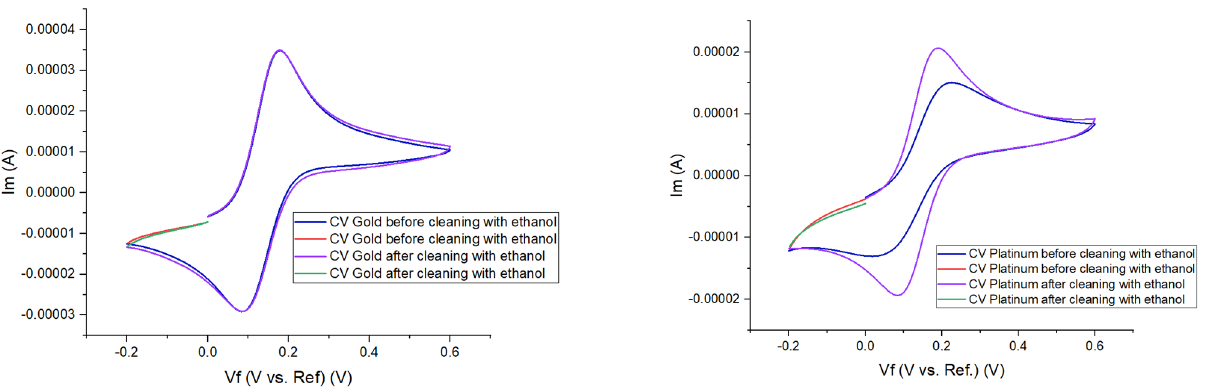
Figure 5. CV of gold and platinum electrodes before and after cleaning with ethanol: blue/red-CV before cleaning; purple/green-CV after cleaning. Created with OriginPro.